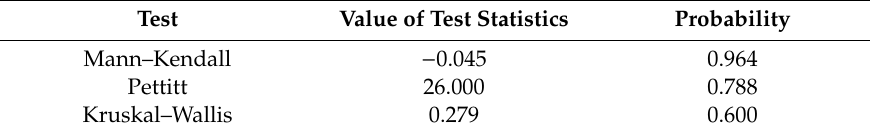
Table 5. Results of the trend analysis conducted by selected tests for the Pr ˛adnik